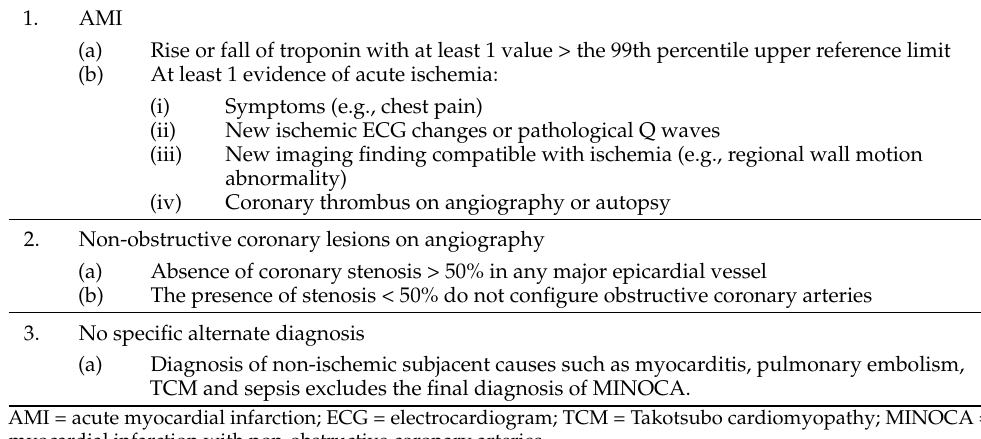
Table 1. Diagnostic criteria for myocardial infarction with non-obstructive coronary